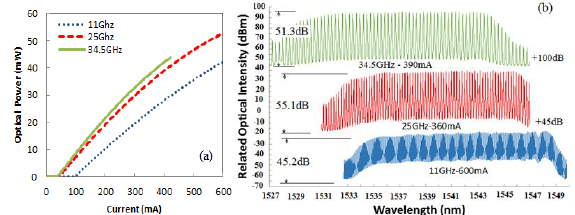
Fig. 2 (a) Light-current characteristics (b) Optical spectra of 11, 25 and 34.5 GHz QD MWLs at 0.01-nm resolution.